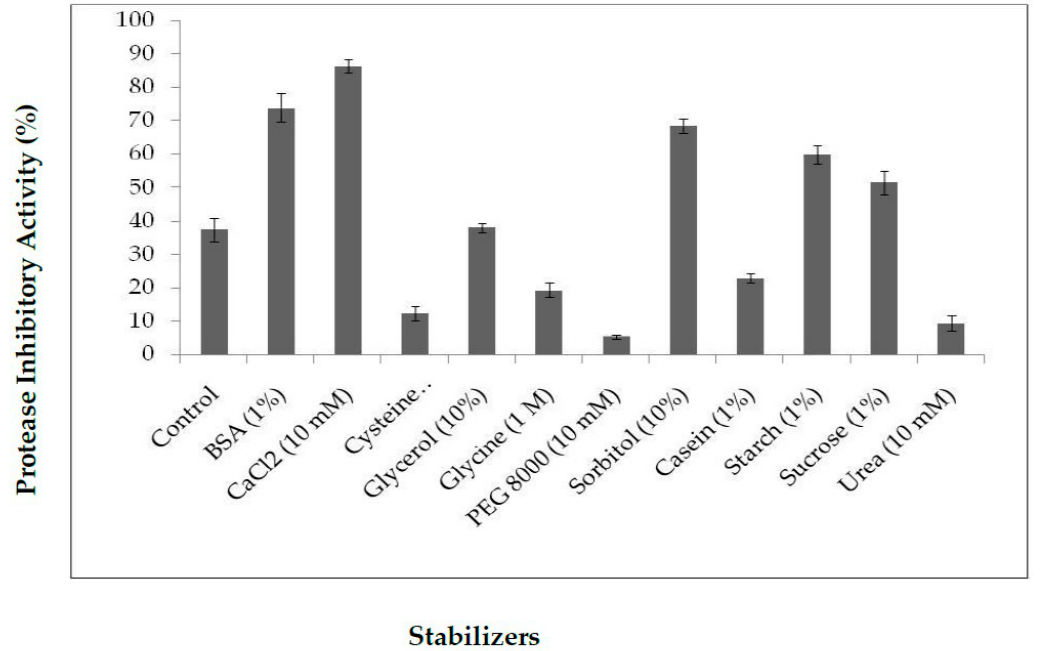
Figure 4. E ff ect of stabilizers on PDInhibitor activity at 70 ◦ C. The inhibitor activity was determined under standard assay conditions (pH 7 and 37 ◦ C) after 4 h of incubation of the inhibitor protein with various thermo stabilizers. The data are the means of triplicate determinations ± SD ( n = 3).